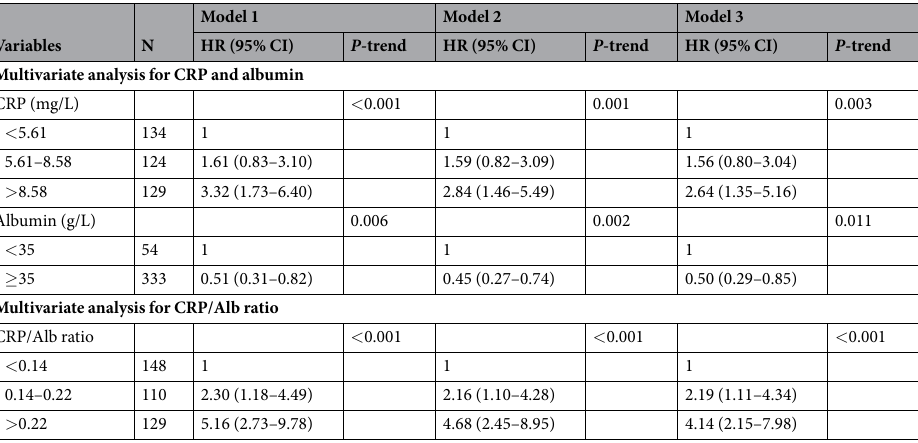
Table 3. COX proportional hazards regression overall model of CRP, albumin and CRP/Alb ratio. Alb, albumin; HR, hazard ratio; CI, confidence interval; CRP, C-reactive protein; Model 1 includes age at baseline interview, sex, body mass index, family history of cancer, patient history of chronic obstructive pulmonary disease, smoking status and drinking habit. Model 2: model 1 plus tumor type, cancer stage and treatment. Model 3: model 2 plus history of chronic liver disease and white blood cell count.